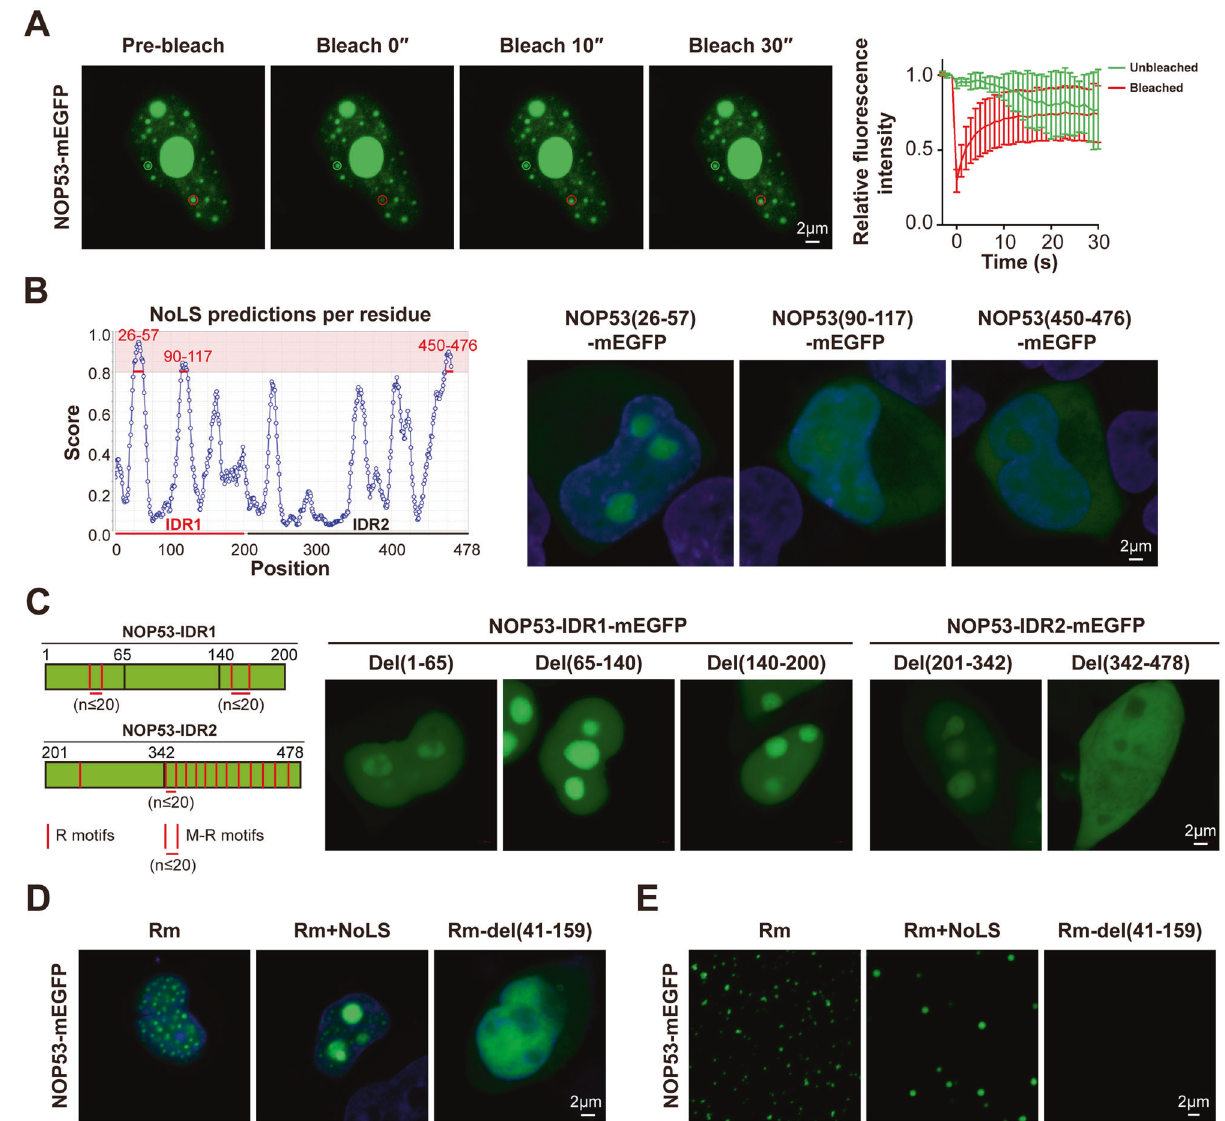
Fig. 4 NOP53 undergoes LLPS independent of the nucleolus. A FRAP of NOP53-mEGFP puncta in the nucleoplasm of HEK293T cells. B The NoLS of NOP53 was analyzed with NOD (www.compbio.dundee.ac.uk/software.html#3Dstructure) and veri fi ed in HEK293T cells. C Schematic of R motifs or M-R motifs distribution in NOP53 sequence and truncation of NOP53-IDR1/IDR2 sequence. R motifs were de fi ned as the sequence pattern, RX n1 R (n1 ≤ 2), while M-R motifs were de fi ned as the sequence pattern, RX n1 RX n2 RX n3 R (n1 ≤ 2, n3 ≤ 2, and n2 ≤ 20). D Distribution of NOP53-Rm-mEGFP, NOP53-Rm + NoLS-mEGFP and NOP53-Rm-del(41-159)-mEGFP in HEK293T cells. E The puri fi ed NOP53- Rm-mEGFP and NOP53-Rm + NoLS-mEGFP protein, but not NOP53-Rm-del(41-159)-mEGFP protein, formed droplets in vitro. One micromolar protein was